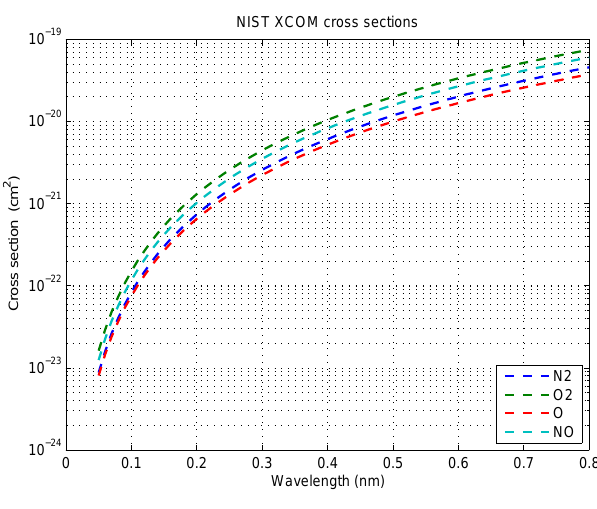
Fig. 1. The X-ray cross sections of the major atmospheric species, as taken from the NIST XCOM data base (Berger et al.,